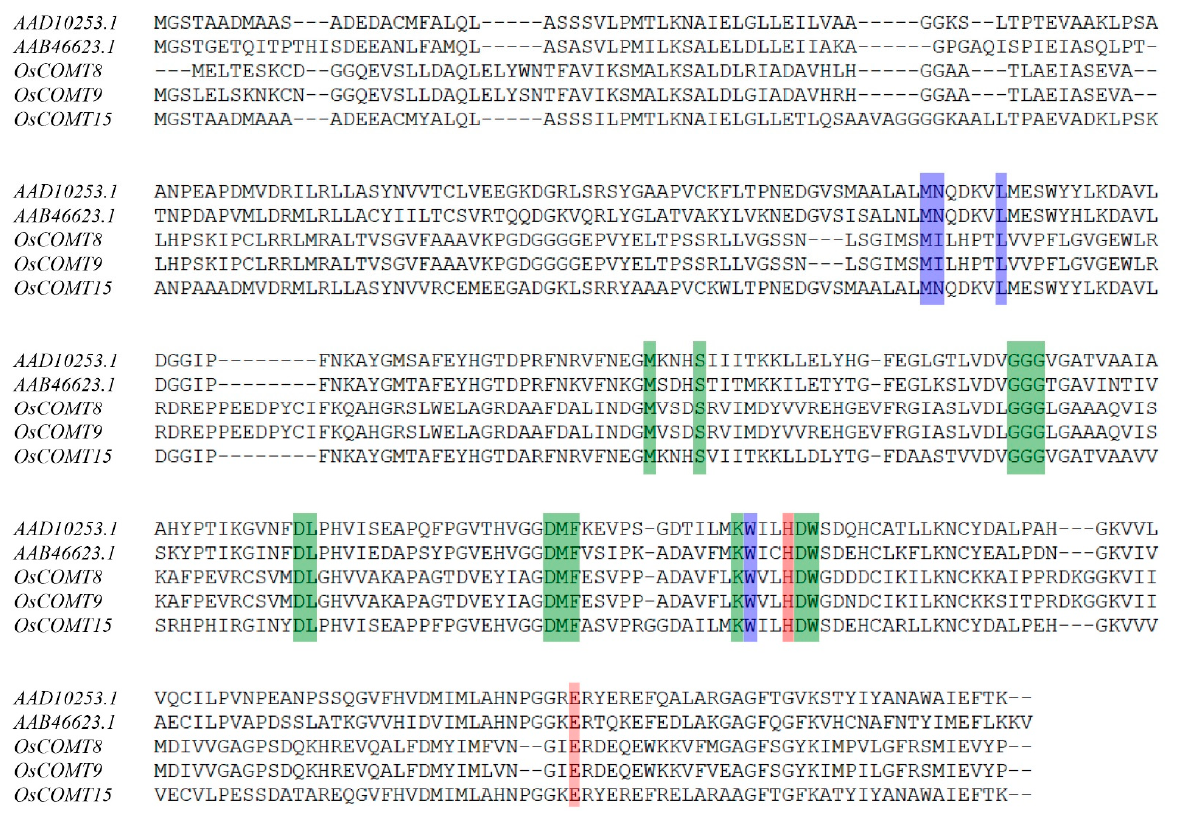
Figure 8. Multiple sequence alignment of OsCOMT8 , OsCOMT9 and OsCOM15 with known COMT genes. Purple: Substrate; Green; SAM binding; Orange: catalytic residues.